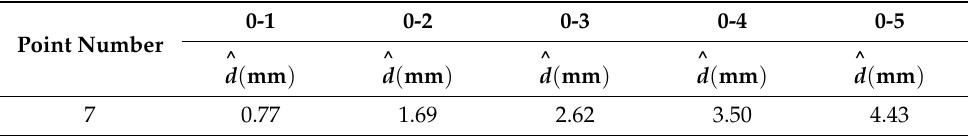
Table 1. Results of measuring displacements by applying 2D deflection